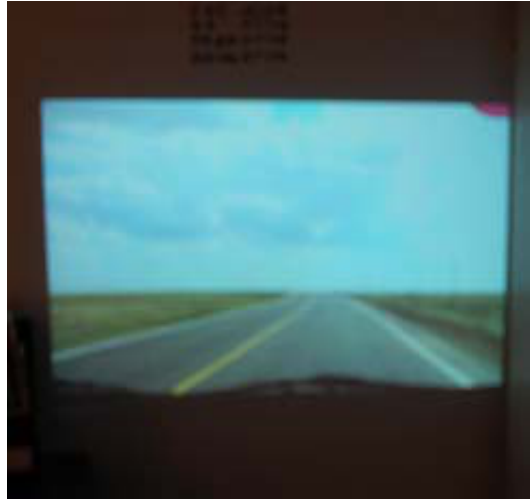
Fig.1. The straight line editing video